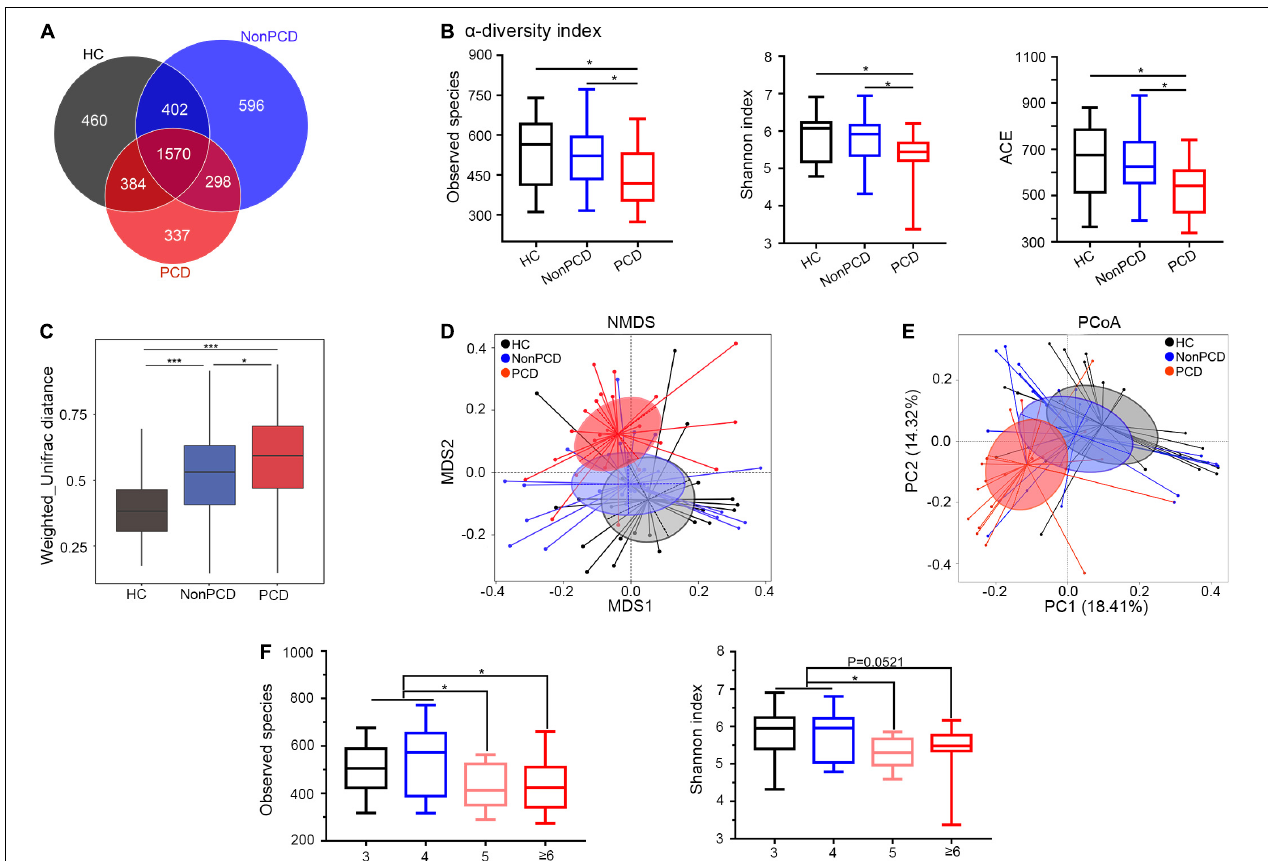
FIGURE 2 | Attenuated alpha diversity and altered gut microbiota composition in patients with PCD. (A) Overlapping Venn diagram showing the operational taxonomic units (OTU) of microbial taxa among these three groups. (B) Decreased alpha-diversity of gut microbiota in the PCD group by observed species, Shannon index and ACE. (C) Box plot for beta-diversity index in three groups based on weighted Unifrac distance (Wilcox rank sum test). (D) The microbial distributions among three groups were indicated by non-metric multidimensional scaling (NMDS) plot with cluster. (E) Differences of bacterial taxa were analyzed by principal coordinate analysis (PCoA) among these groups. (F) Observed species and Shannon index distributed in four classes based on BSS. Data are expressed in box plot as Min to Max; n = 22 for HC, 25 for Non-PCD, and 23 for PCD patients. * p < 0.05 *** p < 0.005. BSS, Bristol stool score.